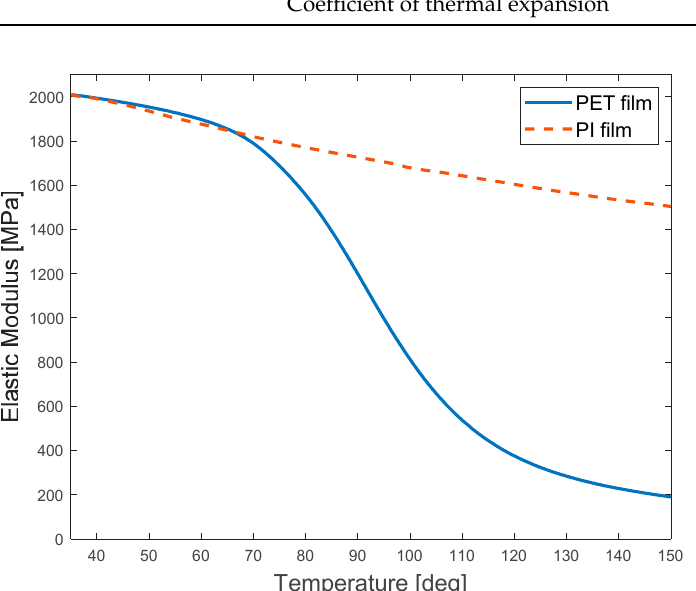
Figure 5. Changes in the elastic modulus of the PET and PI films as a function of temperature.